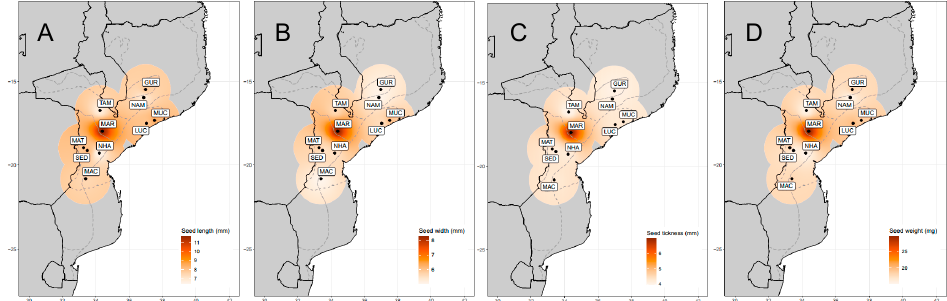
Figure 2. Spatial distribution of seed length ( A ), seed width ( B ), seed thickness ( C ) and seed weight ( D ). Names of landraces follow Table 1.